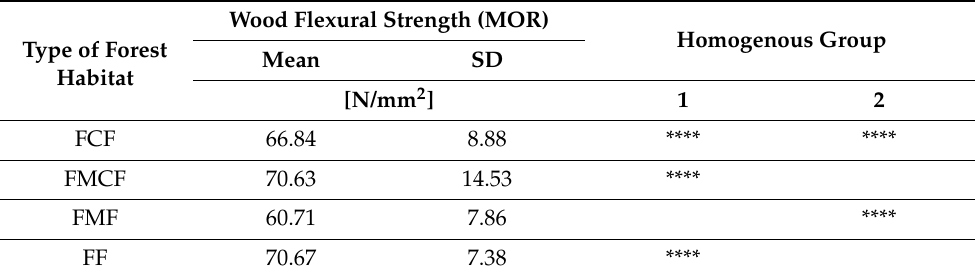
Table 2. Statistically homogeneous groups based on the Tukey HSD test for the wood strength in the forest habitats at a 95% confidence interval.